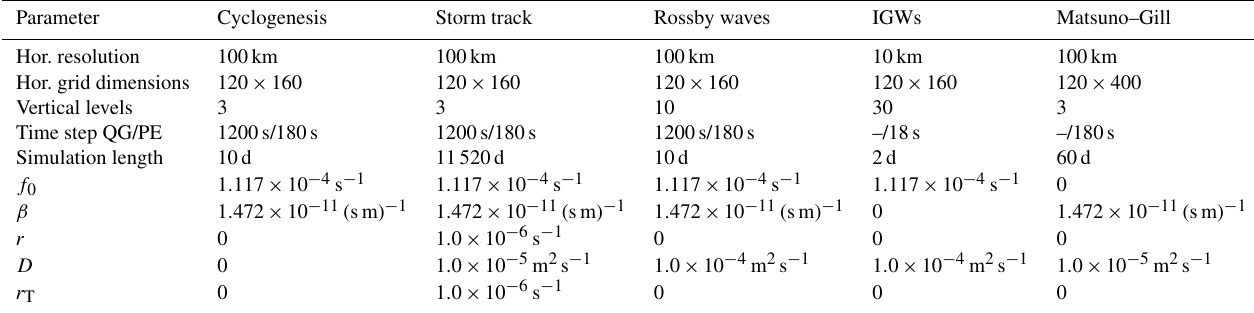
Figure 1. Screenshot of the graphical user interface for Bedymo taken while the model is running. Table 3. Summary of pertinent model parameters for the test setups used to evaluate the model. The first four columns represent the four mid-latitude test cases discussed in Sect. 3.1, with IGW being short for inertia–gravity wave. The fifth column represents the coupled test case, which is the Matsuno–Gill-like response to equatorial heating discussed in Sect.